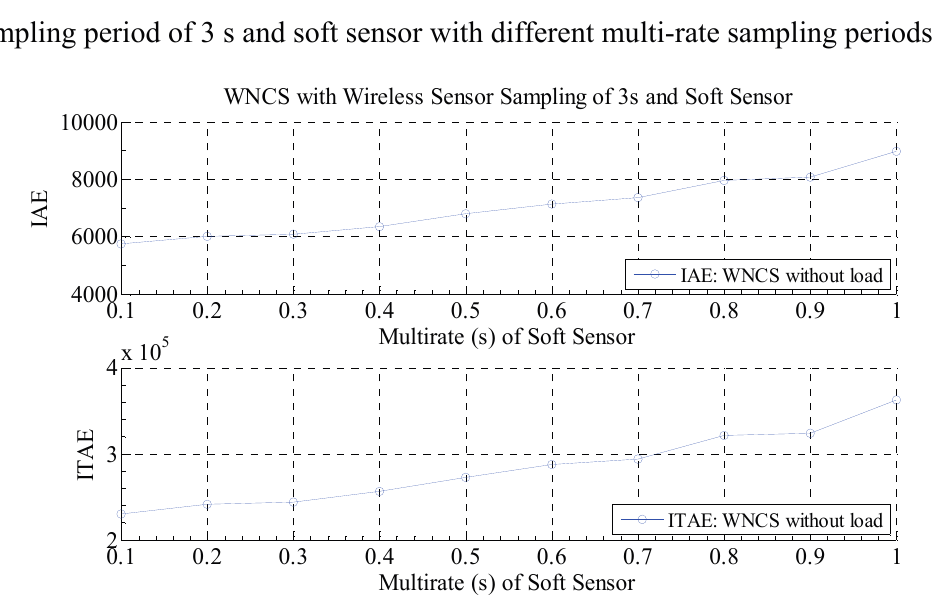
Figure 13. Performance indexes of the WNCS with disturbance: wireless sensor with real sampling period of 3 s and soft sensor with different multi-rate sampling